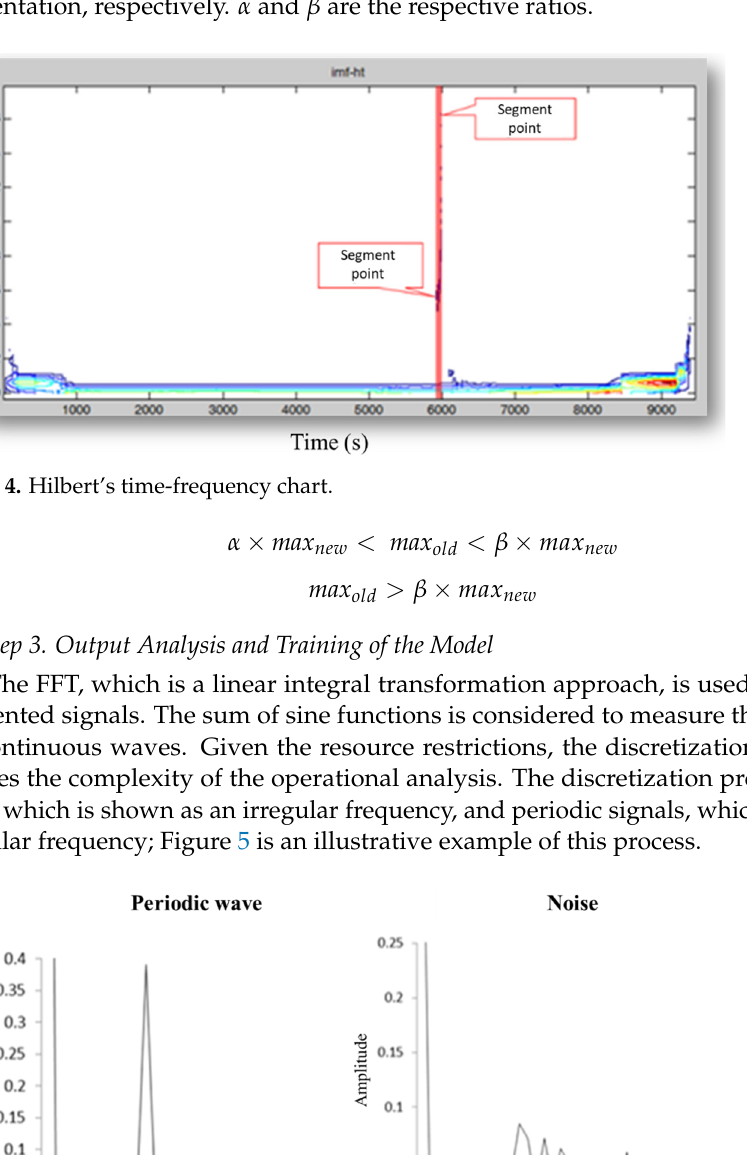
Figure 3. Filtering of a Wavelet Transform.